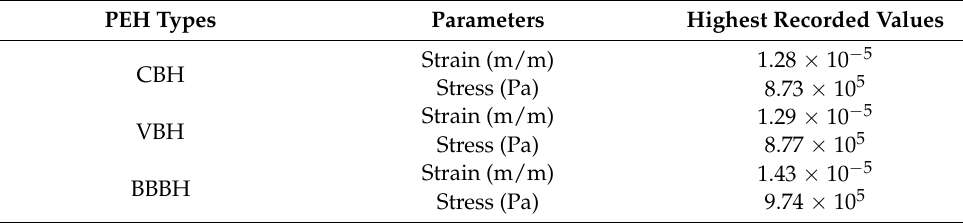
Table 6. Highest stress and strain achieved by various PEH under static